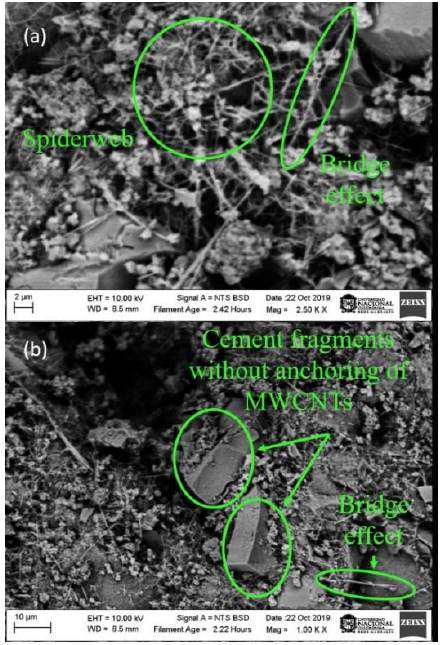
Figure 8. Scanning electron microscope (SEM) images of Portland cement specimens with a dispersion solution addition at 190 J/g. ( a ) 2 μ m ( b ) 10 μ m.